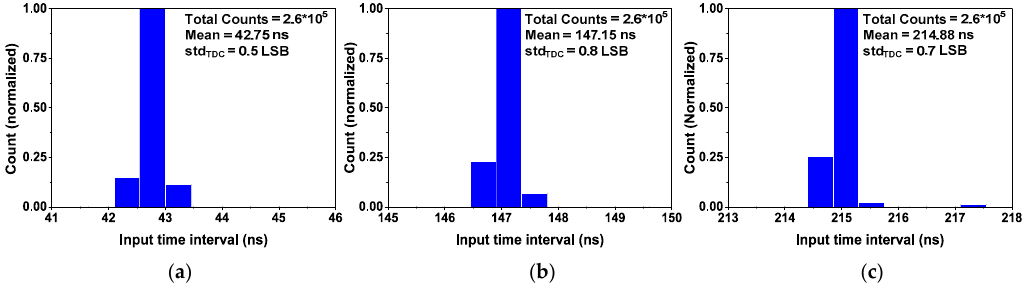
Figure 18. Single-shot measurement. ( a ) T input = 41.2 ns, ( b ) 148.3 ns, ( c ) 217.7 ns.